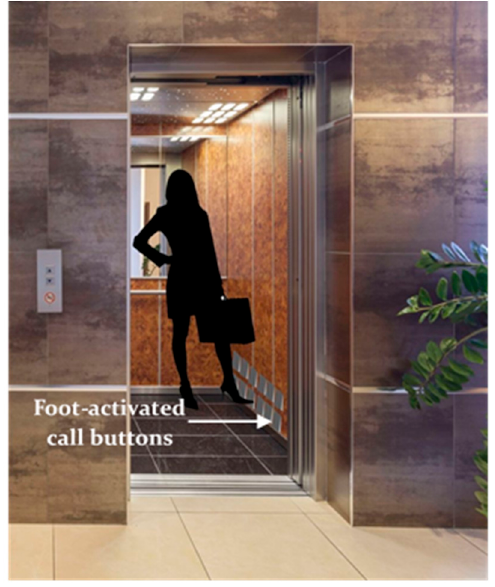
Figure 3. Toe-To-Go hands-free lift showing foot-activated call buttons.